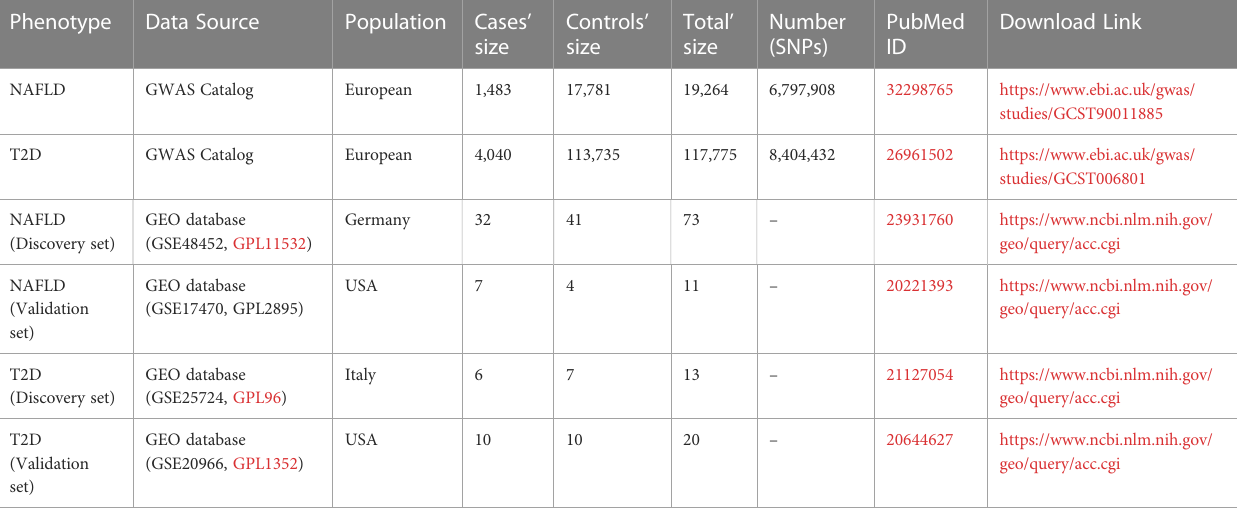
TABLE 1 Data source information